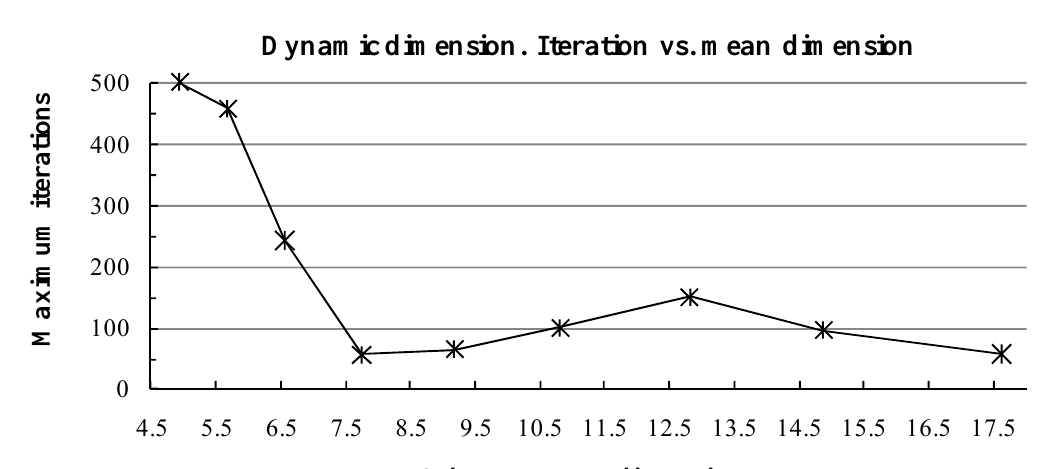
Subspace mean dimension